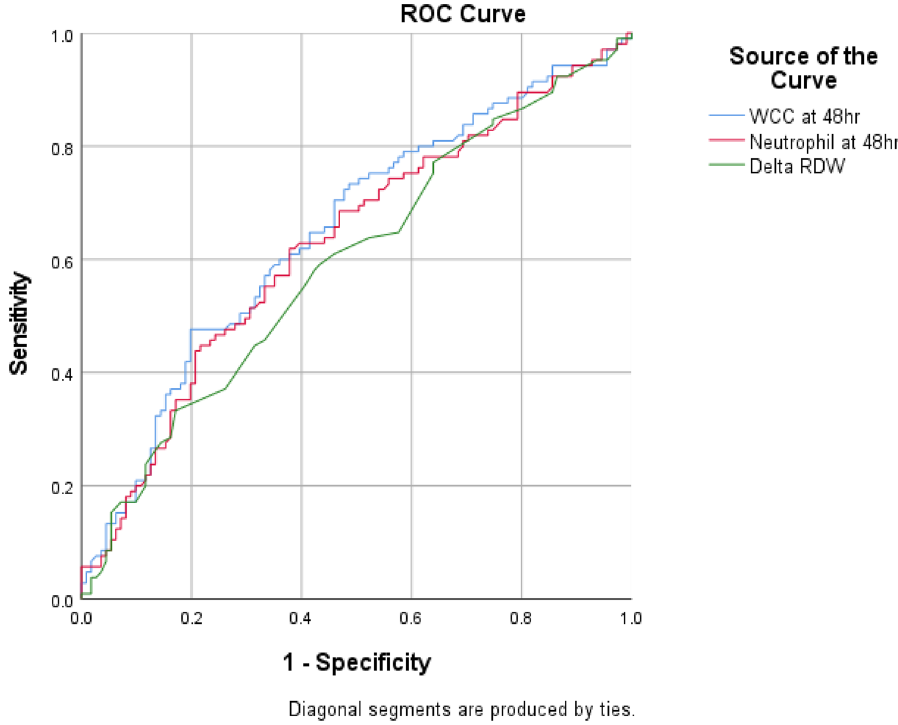
Figure 3. Receiver operating characteristic (ROC) curves to compare the diagnostic performance of laboratory parameters in differentiating viral versus bacterial